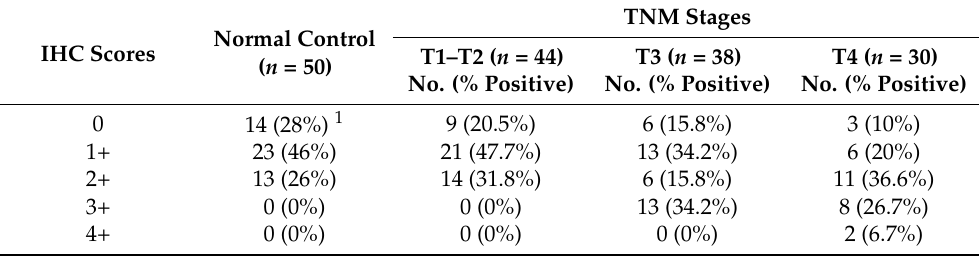
Table 2. FGFR3 positivity rates in renal pelvis tissues from Asian patients with upper tract urothe- lial carcinoma (UTUC).